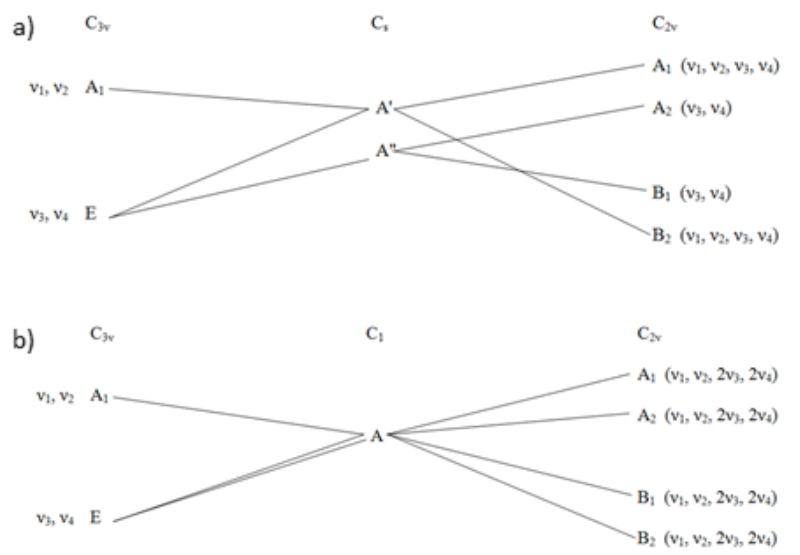
Figure 4. ( a ) Internal vibrations (four crystallographic types) of NH 3 molecules at special symmetry positions C s in compound 3-Mn ; ( b ) Internal vibrations (three different crystallographic types) of NH 3 molecules at positions of trivial symmetry, C 1 , in compound 3-Mn. ν 1 –symmetric stretch.; ν 2 – symmetric bend.; ν 3 – antisymmet ric stretch; ν 4 – antisymmetric bend.